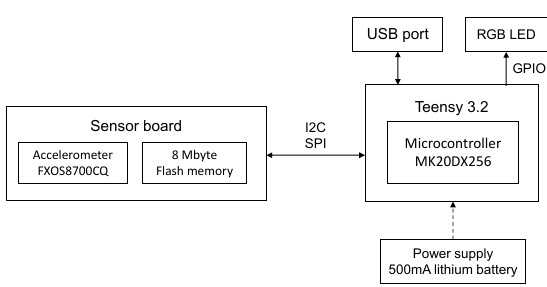
Figure 4. Block diagram of the test bench used for the data capture.